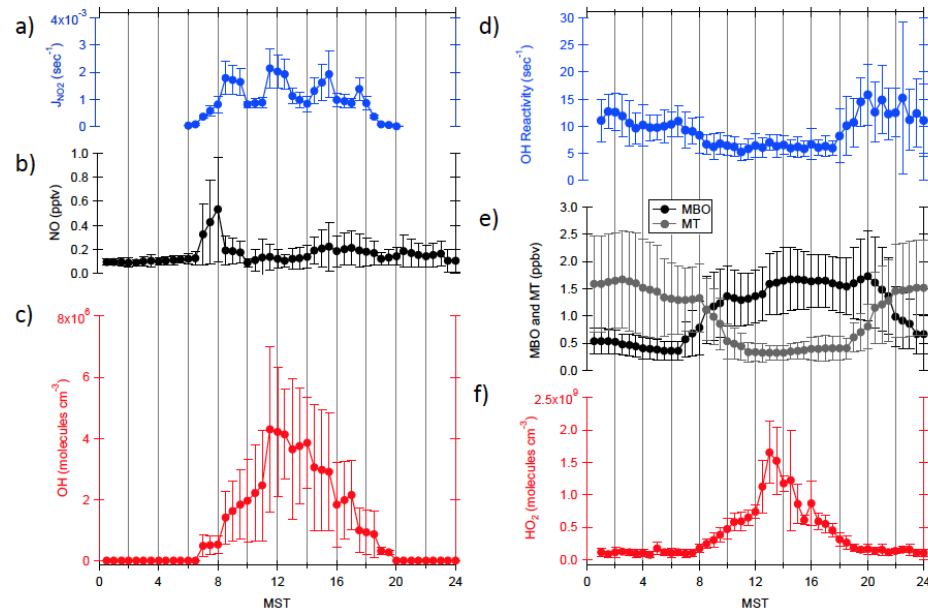
Fig. 2. Averaged diurnal cycles of (a) J NO , (b) NO, (c) OH, (d) OH reactivity and (e) MBO and MT (f) HO 2 during the BEACHON-ROCS 2 field campaign in August